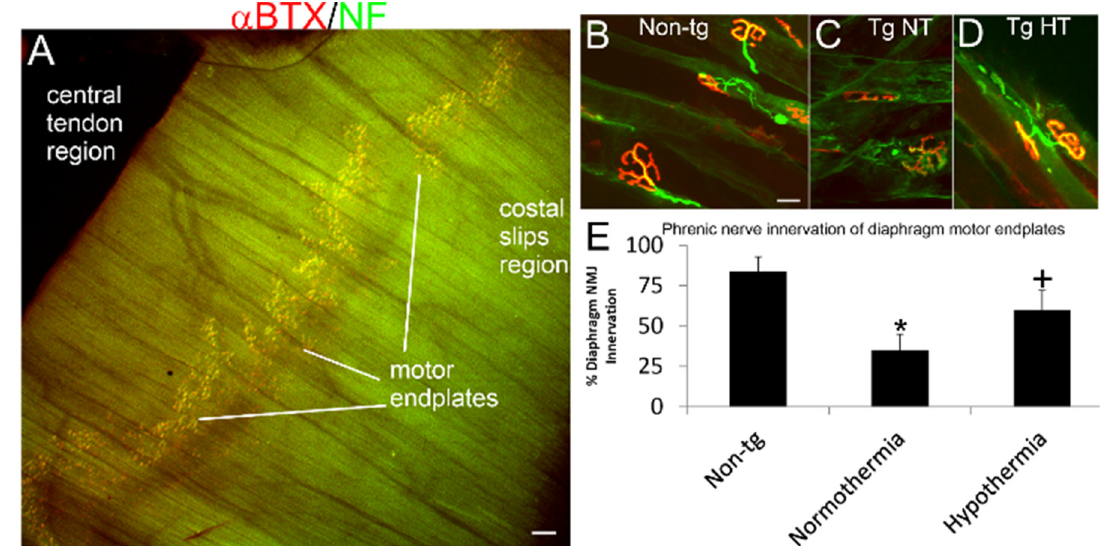
Figure 4. Cold acclimation preserves diaphragm NMJ integrity in hSOD1-G93A tg mice. ( A ) Low magnification image showing the band distribution of NMJs (yellow) in a mouse hemidiaphragm. Scale bar = 320 μ m. ( B – D ) Innervation of diaphragm motor endplates (visualized by Alexa 594-conjugated α -bungarotoxin, α BTX, red) by motor neuron axons (visualized by immunofluorescence for neurofilament, NF, green) in a non-tg mouse ( B ) and in hSOD1-G93A tg mice that were ambient normothermic ( C , Tg NT) and cold acclimated hypothermic ( D , Tg HT) at 12 weeks of age. Scale bar (in B , same for C , D ) = 19 μ m. ( E ) Counts of innervated motor endplates in a diaphragm of non-tg mice and hSOD1-G93A tg mice that were ambient normothermic or cold acclimated hypothermic showed significant loss (* p < 0.01) of innervation in normothermia hSOD1-G93A tg mice and rescue (+ p < 0.05) of innervation in cold acclimated hypothermia hSOD1- G93A tg mice.